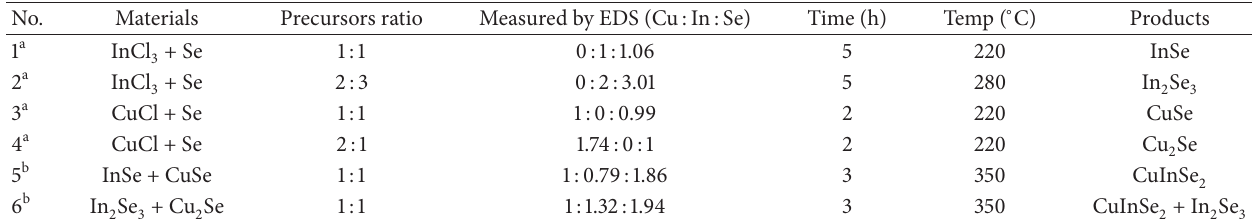
Table 1: Experimental conditions and